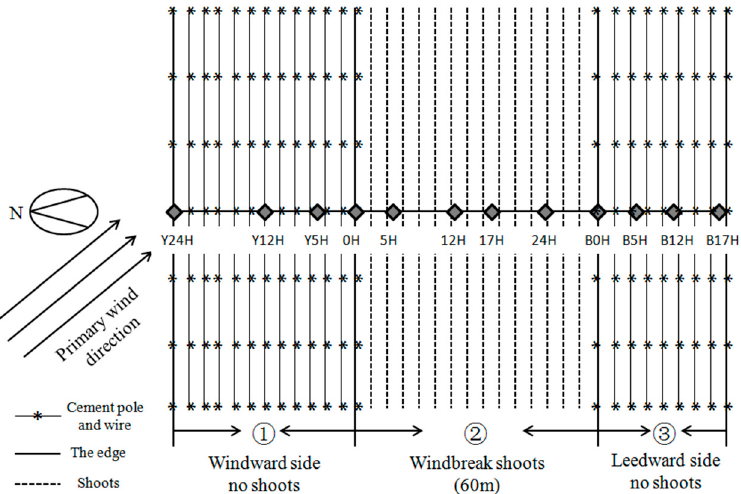
Figure 4. Schematic diagram of field wind speed measurement test layout. The field plots Y24H, Y12H, and Y5H at the windward side, that is, 48, 24, and 10 m away from the windward edge of the windbreak; the field plots 0 H, 5 H, 12 H, 17 H, and 24 H in the windbreak means far away from the windward edge 0, 10, 24, 34, 48 m; the field plots B0H, B12H, B17H at the leeward side means far away from the leeward edge 0, 24, 34m. The width of this windbreak was 60 m (0 H–30 H). The data has been modified based on the study of Wang